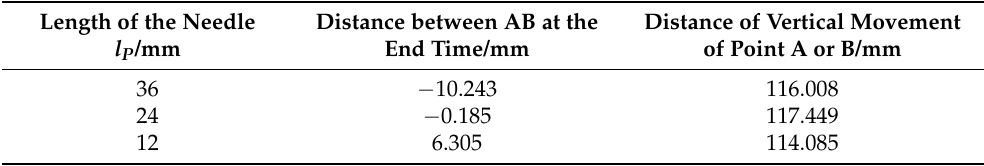
Table 1. Motion distance of the point under different needle